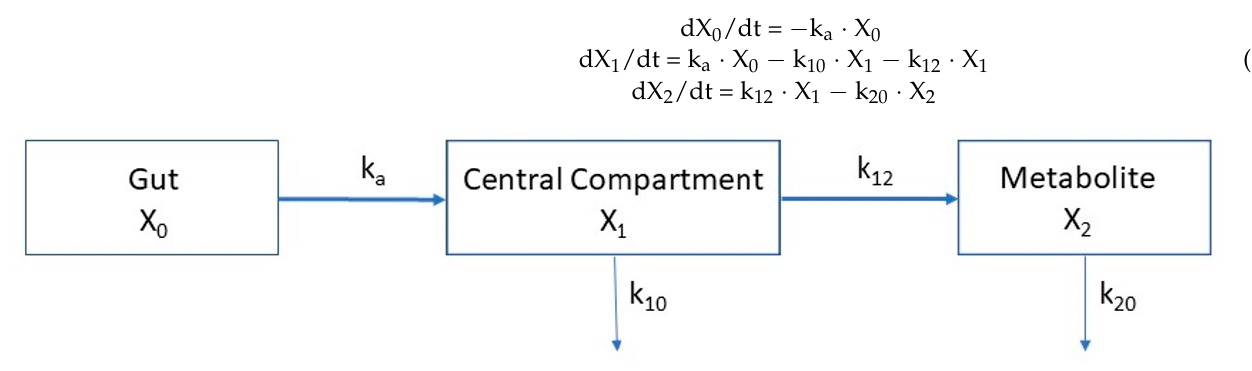
Figure 7. Three-compartment model for the absorption of erythritol/xylitol and the conversion into erythronate.